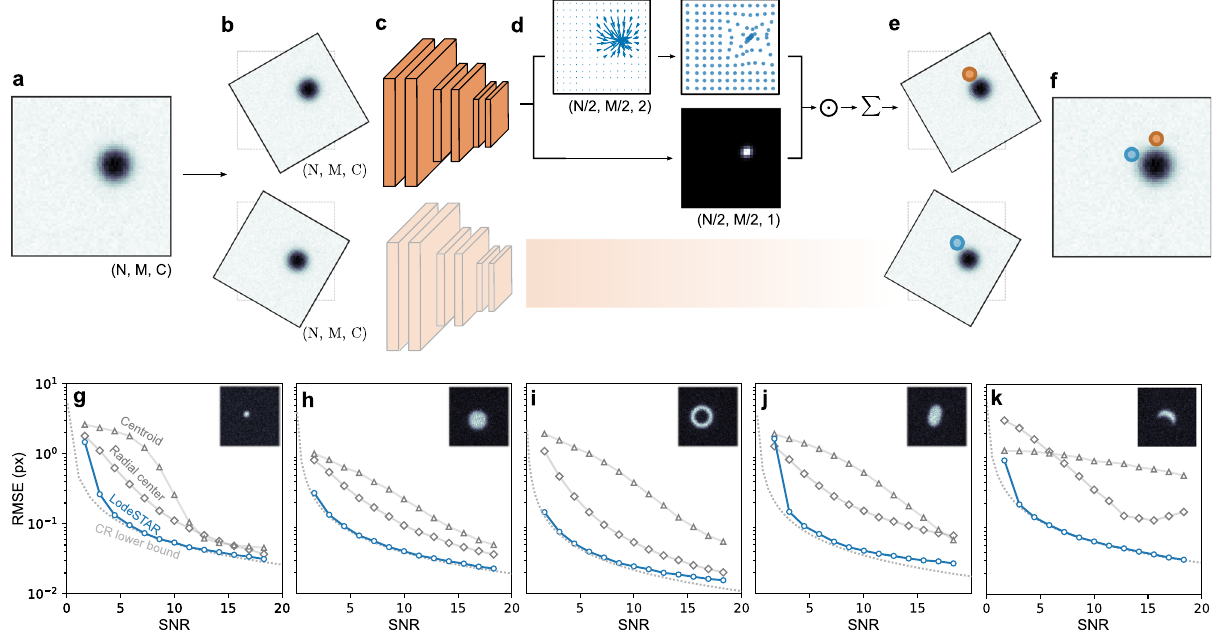
Fig. 1 | LodeSTAR single-shot training and performance. a Example image of a single particle used to train the neural network ( N × M pixels, C color channels). b Twocopiesoftheoriginalimagetransformedbytranslationsandrotations. c The transformed images are fed to a convolutional neural network. d The neural net- workoutputstwotensors(featuremaps), eachwith N /2× M /2pixels:One (top)isa vector fi eld where each pixel represents the direction and distance from the pixel itself to the object (top left, blue arrows), which is then transformed so that each pixel represents the direction and distance of the object from the center of the image (top right, blue markers). The other tensor (bottom) is a weight map (nor- malized to sum to one) corresponding to the contribution of each element in the topfeaturemaptothe fi nalprediction. e Thesetwotensorsaremultipliedtogether and summed to obtain a single prediction of the position of the object for each